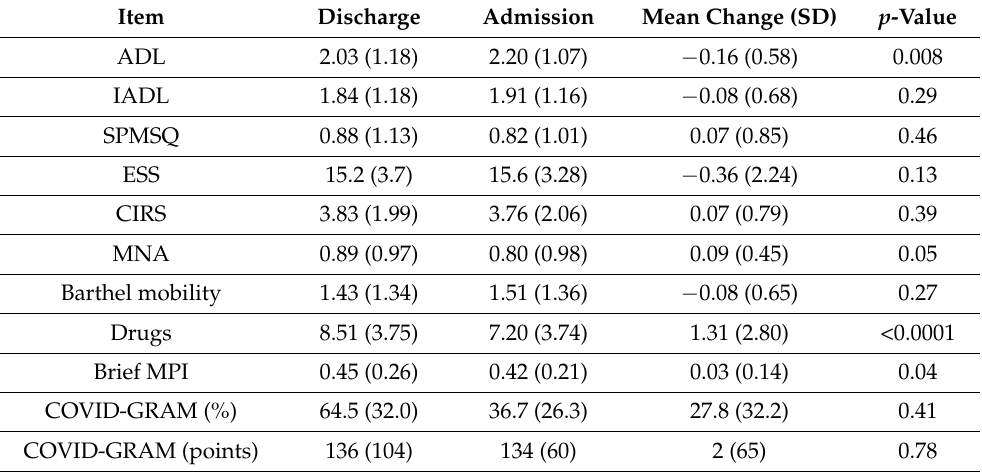
Table 2. Changes in multidimensional prognostic index parameters and in COVID-GRAM score between hospital discharge and